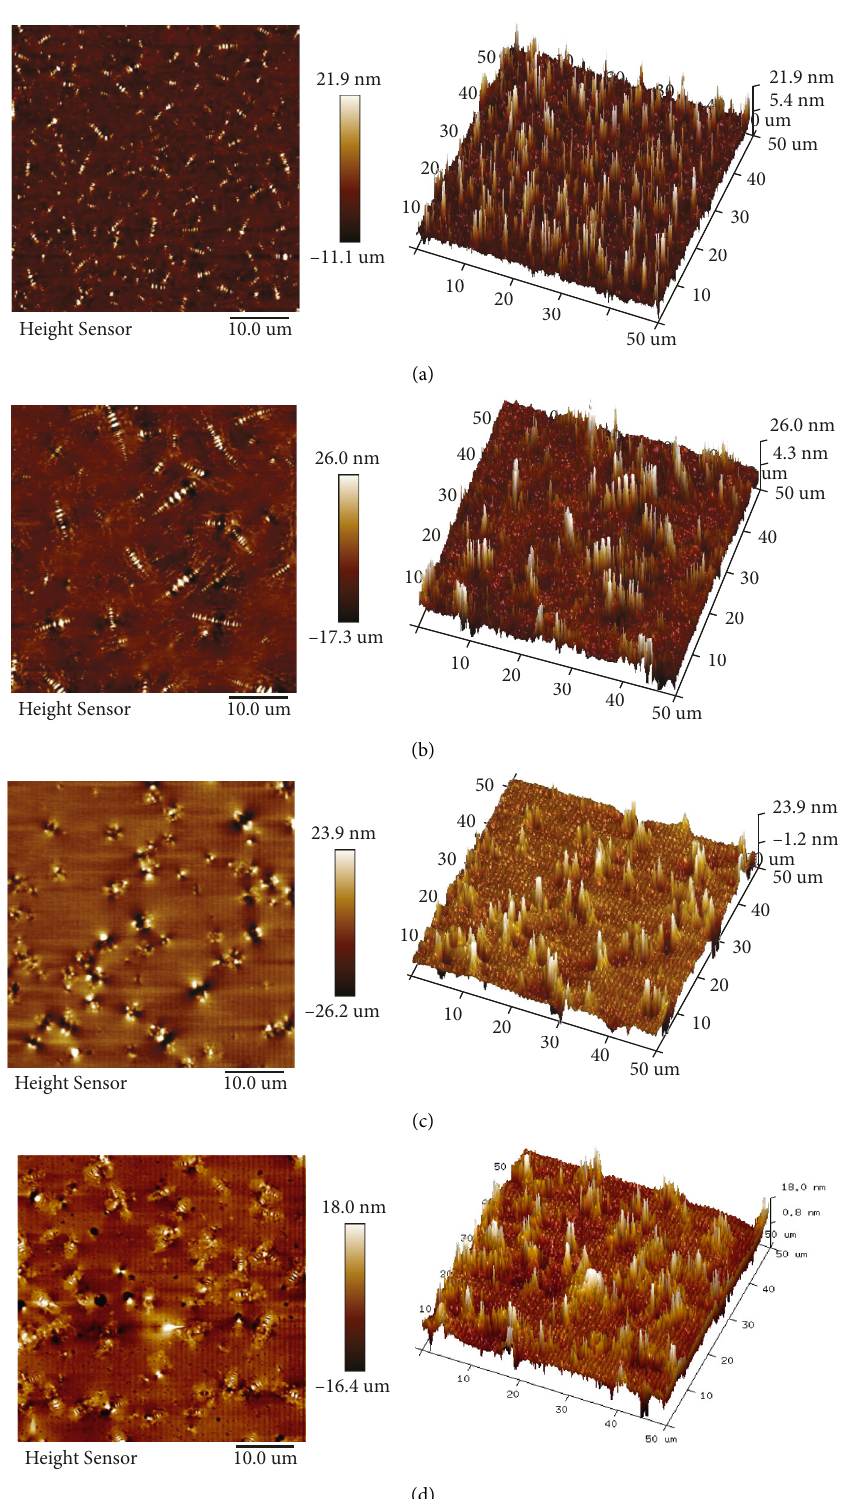
Figure 4: Asphalt AFM scan results: (a) original asphalt, (b) aged asphalt, (c) WEOB-rejuvenated asphalt, (d) and WEOB-S-rejuvenated